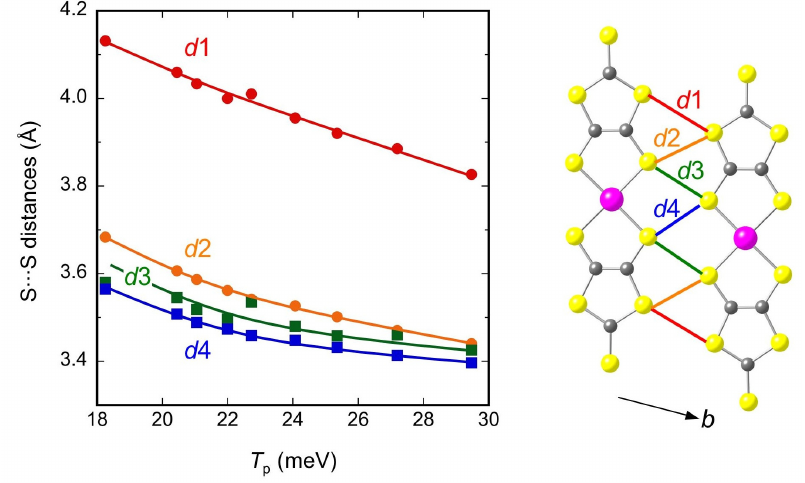
and intermolecular S···S distances (Å) responsible for T p